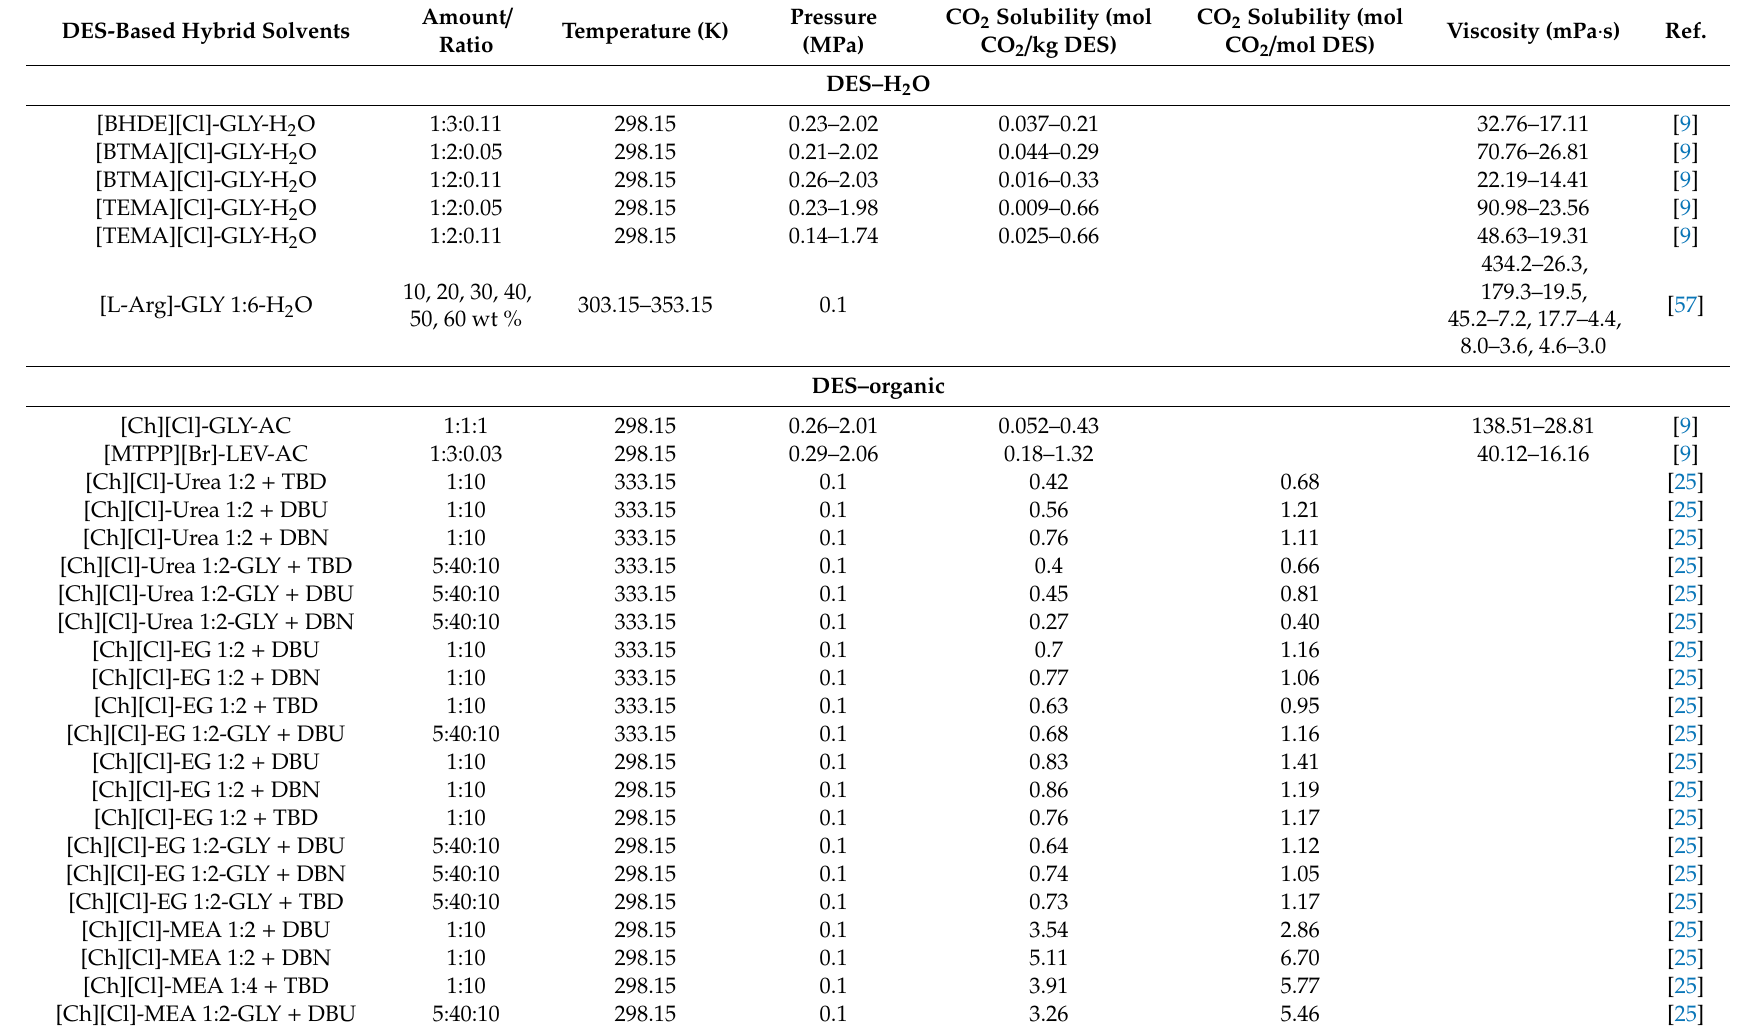
Table 4. CO 2 solubilities and viscosities of deep eutectic solvent (DES)-based hybrid solvents. DES-Based Hybrid